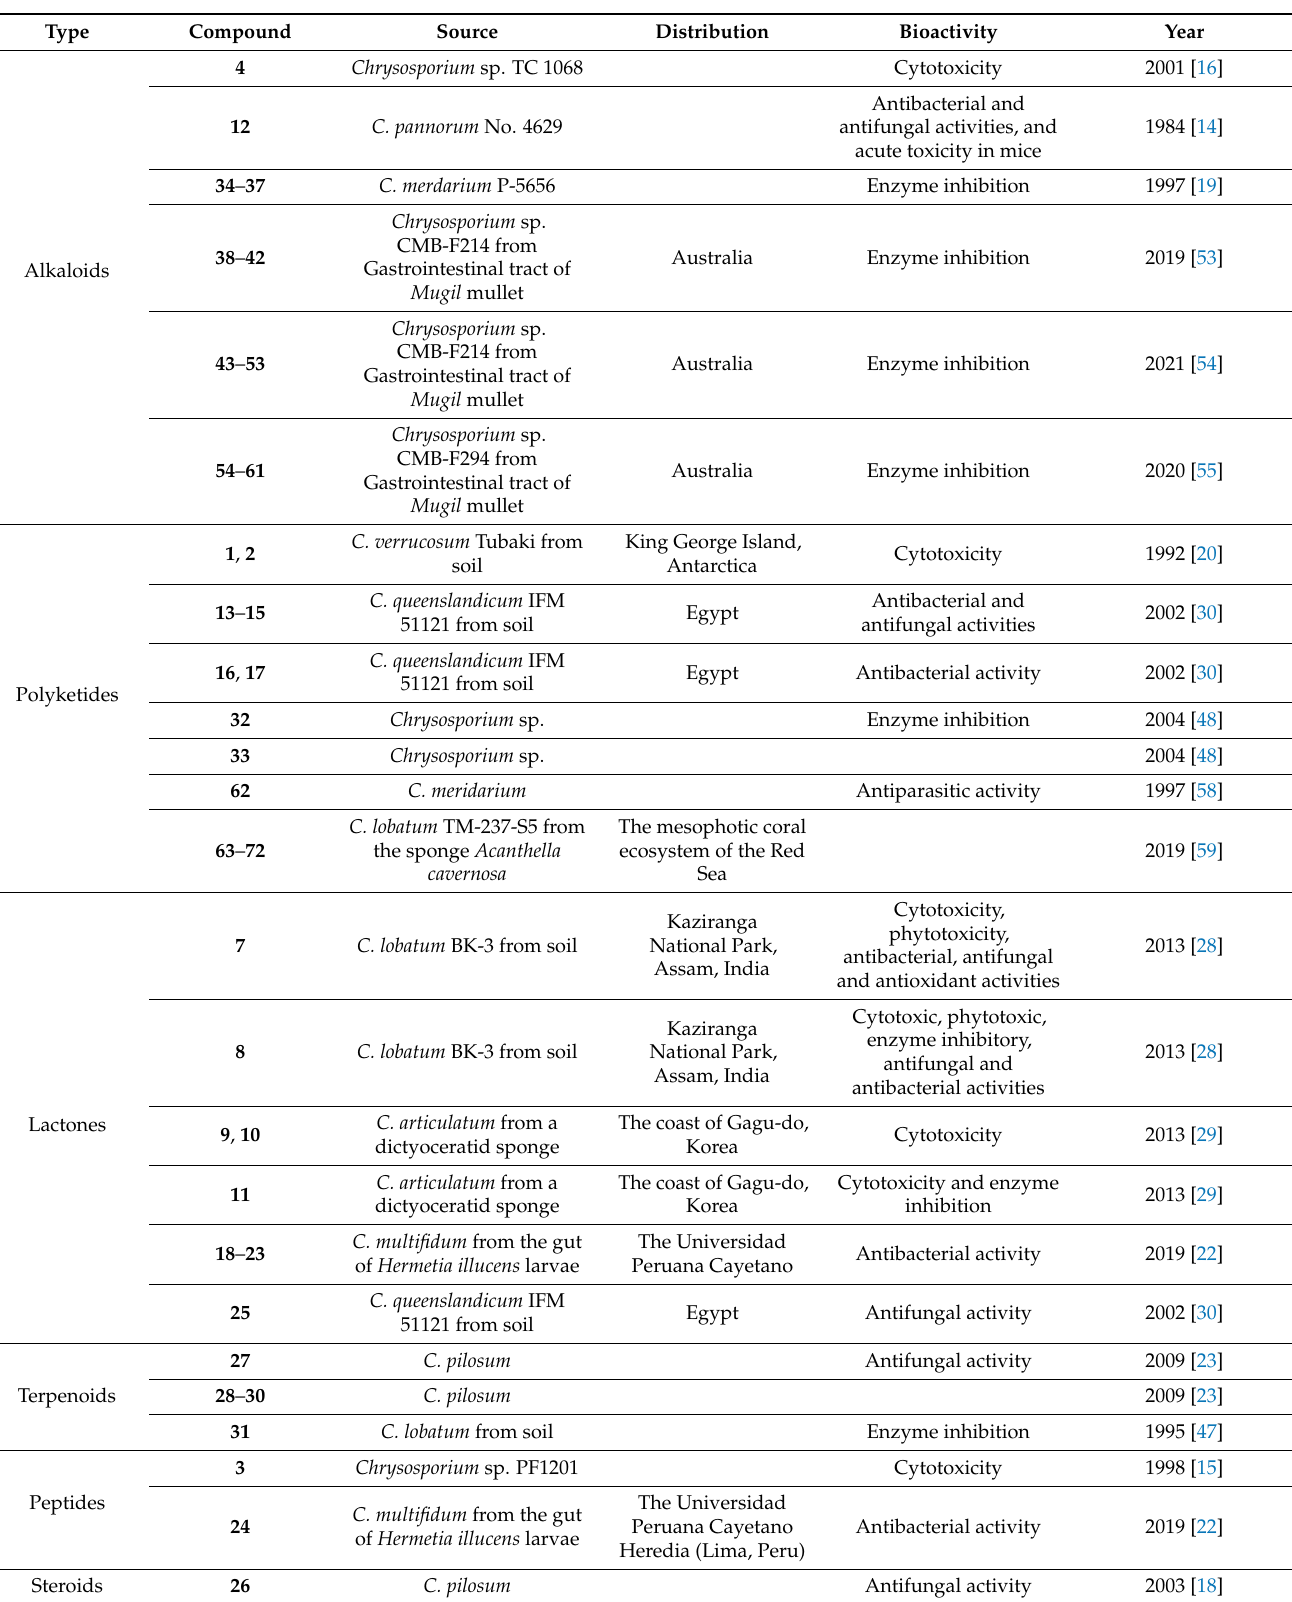
Table 4. Compounds isolated from Chrysosporium in